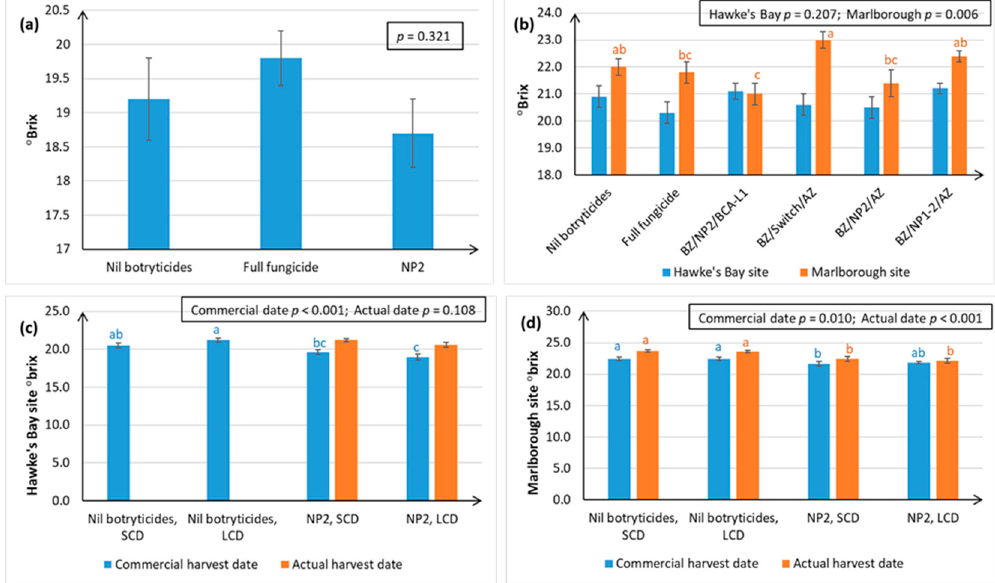
Figure 8. Fruit maturity (°Brix) in Sauvignon Blanc berries, assessed at harvest in April. Treatments are described in full in Tables S1 and S2, and briefly in Figures 1 and 3. Error bars indicate standard errors, boxed values show ANOVA probabilities, and different letters indicate statistically significant differences from LSD ( p ≤ 0.05), only presented when the ANOVA p ≤ 0.05. The concentration of the active ingredient in the NP formulation is indicated in parentheses for each specific experiment. ( a ) Season i, Hawke’s Bay site, NP2 (5 g/L); ( b ) Season ii, Hawke’s Bay and Marlborough sites, NP1 (5 g/L) and NP2 (5 g/L); ( c ) Season iii, Hawke’s Bay site, new formulation of NP2 (30 mL/L), ° Brix were measured on two dates—the normal commercial harvest date and the actual harvest date, as berries were left on the vines for another week to allow for additional Botrytis development; ( d ) Season iii, Marlborough site, new formulation of NP2 (30 mL/L), Brix° measured on two dates. Data for the Nil botryticide treatments on the actual harvest date are missing in Figure 8c,d because the fruit were accidentally harvested by the commercial pickers.